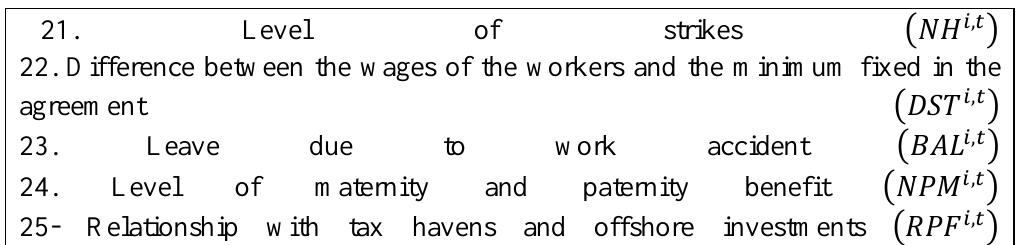
Table 3: Governance